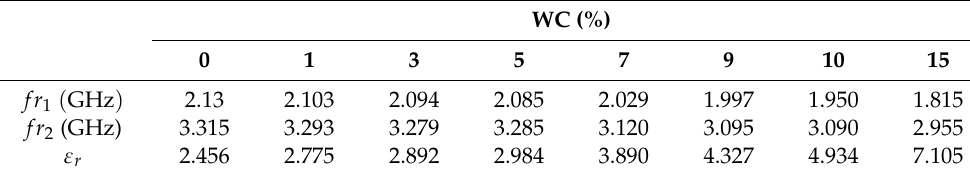
Table 6. Measured results for red clay soil samples.